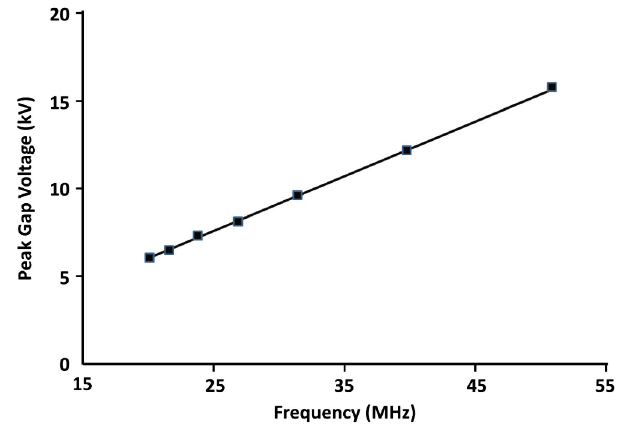
FIG. 25. Frequency dependence of cavity gap voltage.